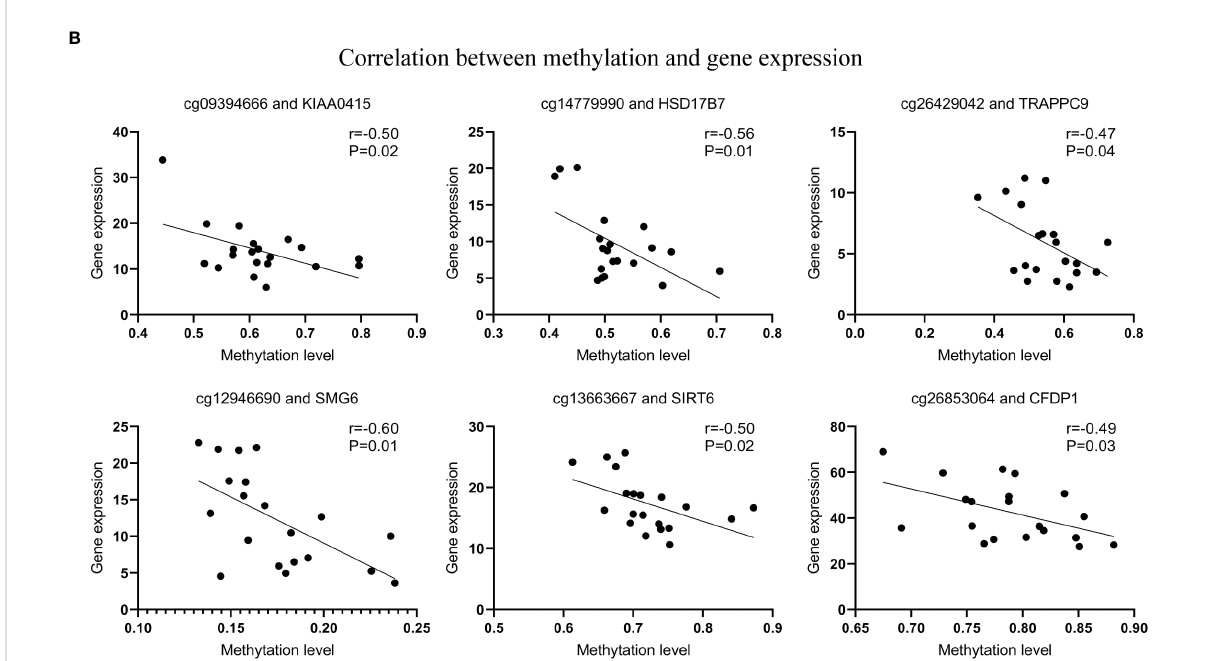
FIGURE 4 DNA methylation can be annotated by other types of epigenetic modi fi cations via eForge, and the correlation between methylation and transcript expression in DMSs. (A) The Annotation of 15 chromatin states for 647 DMSs in blood and epithelial cells. (B) Correlation between methylation and gene